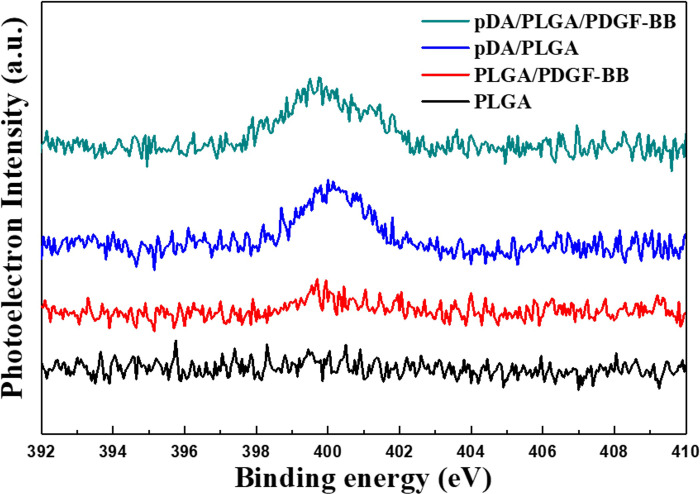
XPS analyses.XPS analyses demonstrated the efficient immobilization of PDGF-BB.